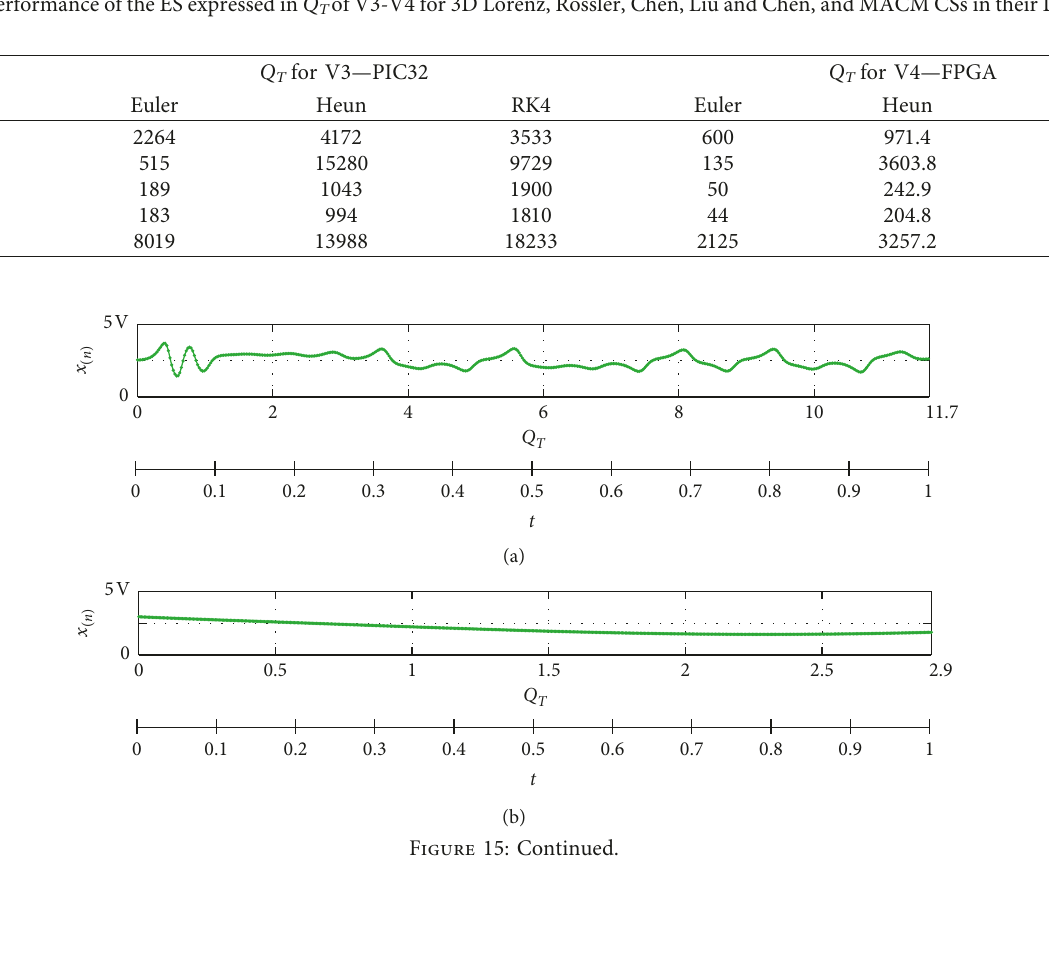
Table 12: Performance of the ES expressed in Q